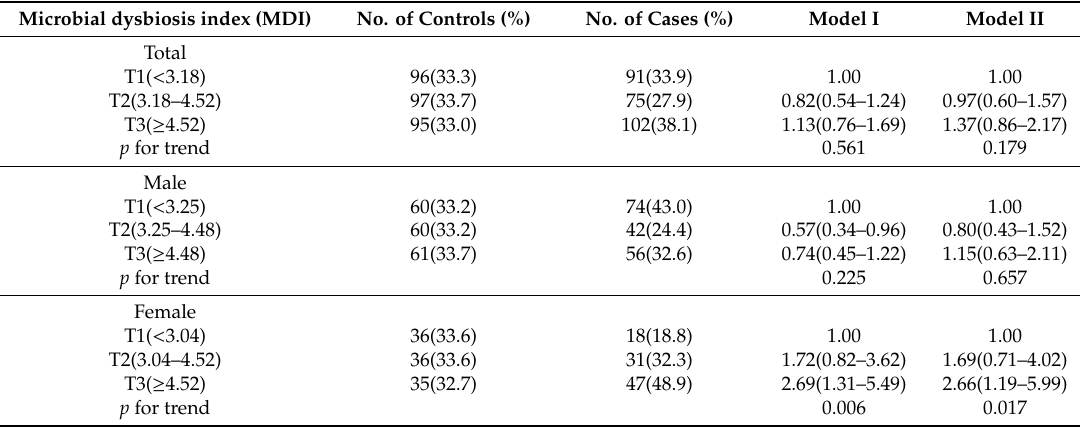
Table 4. Association between the dysbiosis index (MDI) and gastric cancer (GC) risk. Microbial dysbiosis index